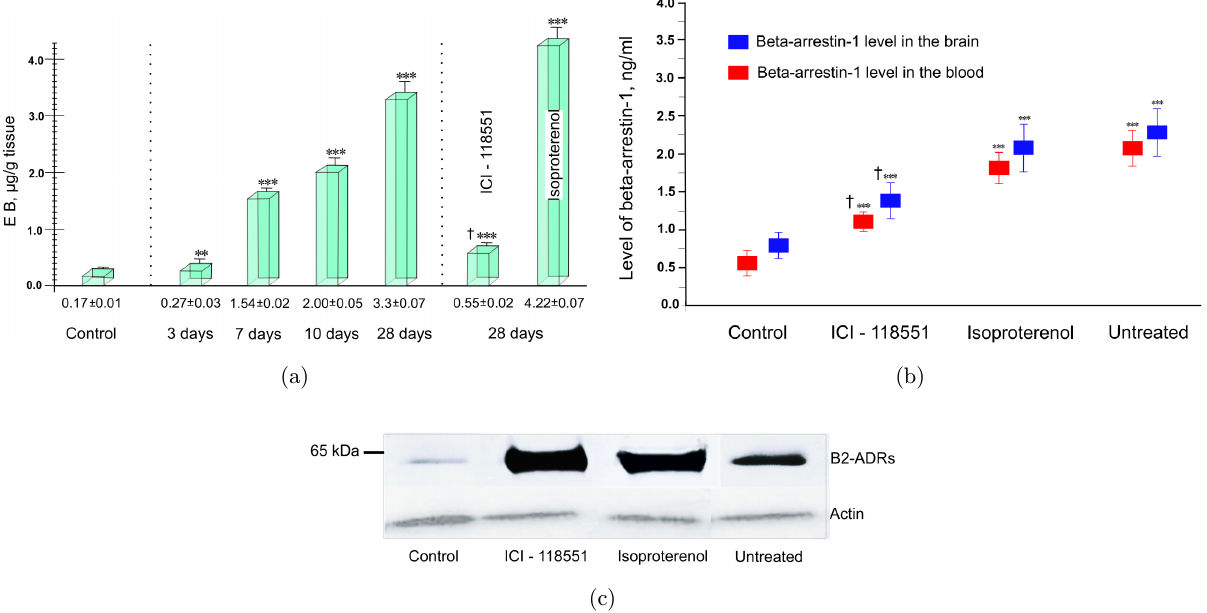
Fig. 3. The expression of B2-ADRs, production of ARRB1 and the BBB permeability in rats with glioma: (a) The spectro- °uorimetric assay of EB leakage shows gradual increase in the BBB permeability to EB related to the degree of glioma progression. The pharmacological blockage of B2-ADRs by ICI-118551 reduced the BBB permeability to EB, while stimulation of B2-ADRs by isoproterenol caused the opposite e®ects. (b) The immunoassay analysis shows increase in production of ARRB1 in both blood and brain related to glioma progression. (c) The blotting analysis demonstrated increase in expression of vascular B2-ADRs in rats with glioma (28 days after GCs implantation). Here, ** – p < 0 : 01; *** – p < 0 : 001 vs. the control group; † – p < 0 : 05 vs. untreated